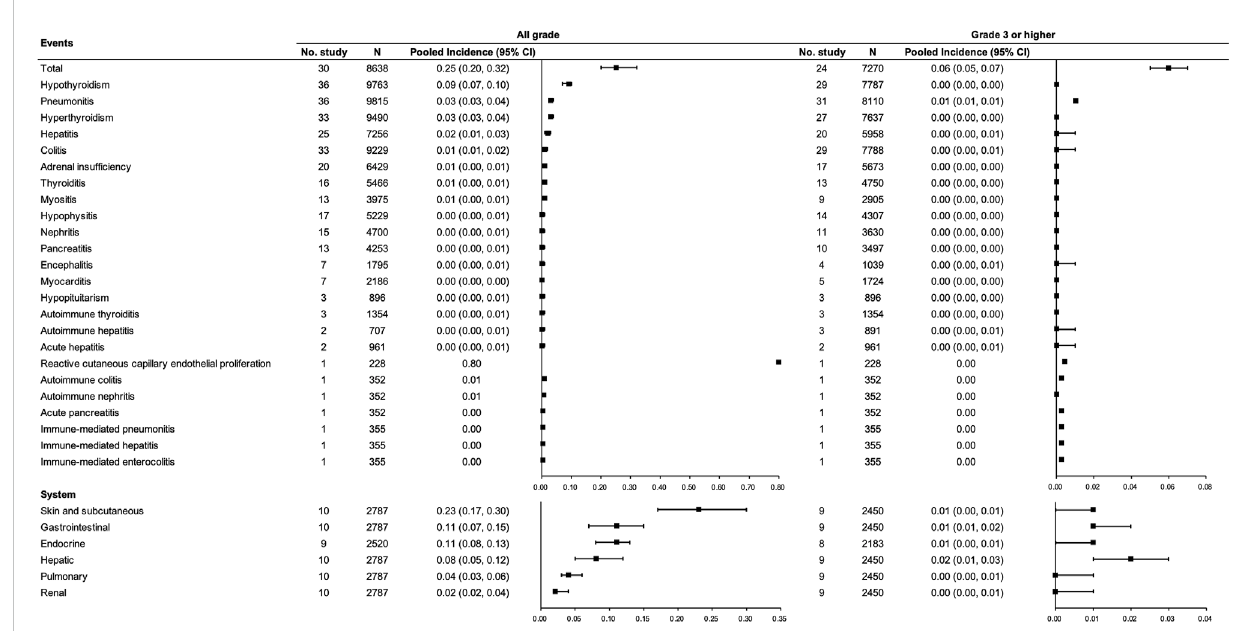
FIGURE 2 Incidence of irAEs for PD-(L)1 inhibitor monotherapy. Note: an incidence of 0.00 indicates a rate < 0.005.